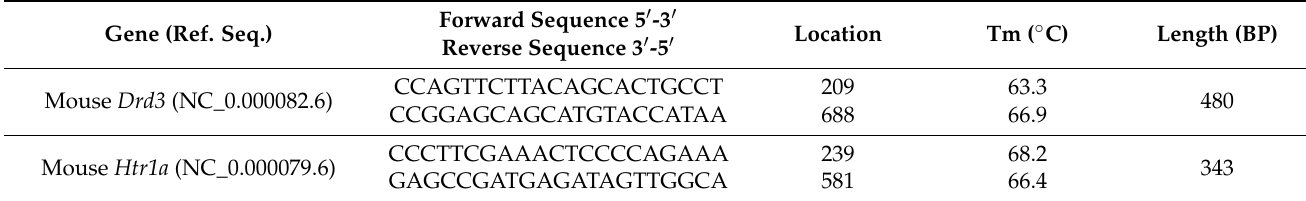
Table 3. Primers used for the sequencing of the mouse Drd3 and Htr1a genes. Gene (Ref.